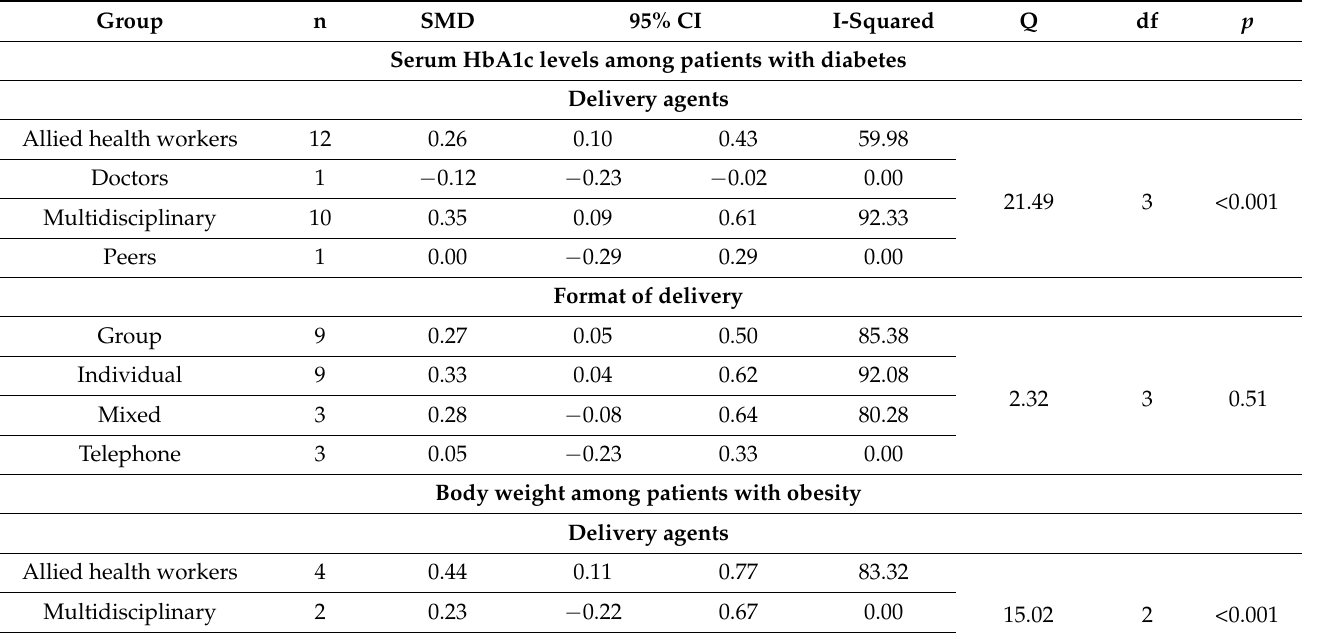
Figure 6. Effectiveness of TPE interventions in improving body weight among patients with obesity. The black blocks present point estimates and 95% confidence intervals for individual studies. The